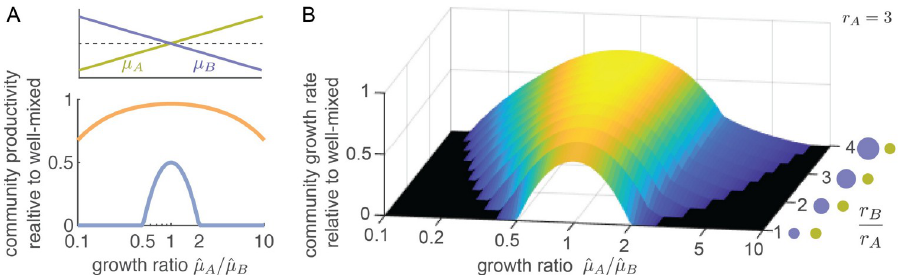
Fig 4. Small interaction neighborhoods can lead to community collapse. (A) When the neighborhood size is small = r = 3, purple line), asymmetric communities, where the cell types have different maximum growth rates, have ( r A B low productivity. When the asymmetry is too large, communities cannot grow (i.e. community productivity is 0) in a spatially structured environment even though they could grow in well-mixed environments. When the neighborhood size is large ( r = r = 30, orange line), the productivity of the spatial community is close to that of the well-mixed A B community even when there is an asymmetry. (B) Increasing the neighborhood size of just one the types is enough to increase the productivity of spatial communities and prevent collapse. r